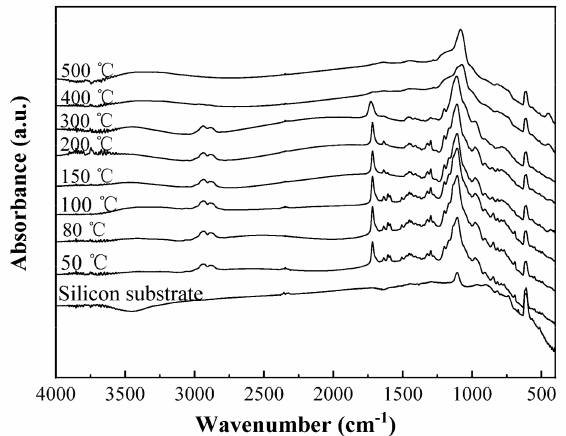
Figure 6. FTIR absorption spectra of the composite films containing 5 wt. % azobenzene and heated at different